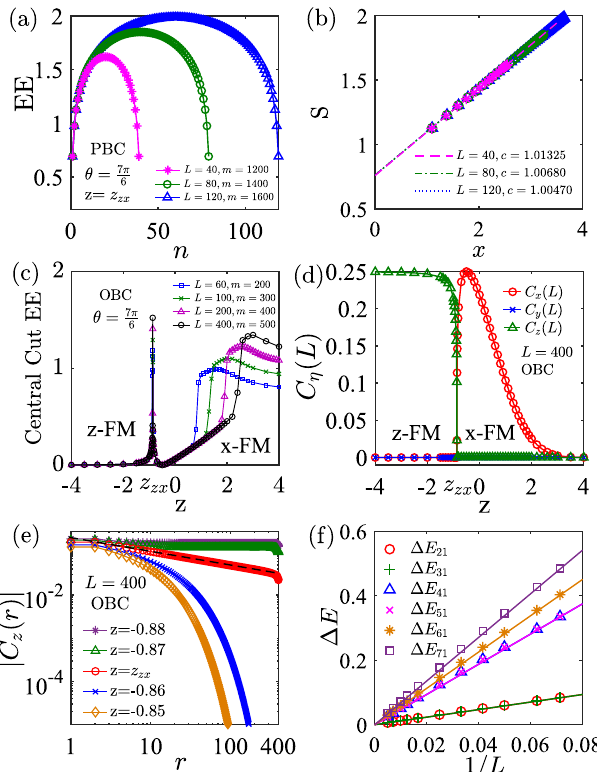
Figure 5. ( a ) and ( b ) show EE and central charge c at the boundary between z -FM and x -FM phase at 0.86602 , by DMRG method with PBC. The dashed lines in ( b ) are fitted by Eq. (28) 7 π/ 6 with z zx θ = − = sin π n ln ( L 1 . ( c ) Central cut EE as a function of z at θ 7 π/ 6 for different L and ) , yielding c with x π L = = = 7 π/ 6 for x , y , z ) as a function of z at θ bond dimension m . ( d ) Spin–spin correlation functions C η ( L ) ( η = = 0.32 , by 400 . ( e ) Spin–spin correlation function C 7 π/ 6 . At the phase boundary, C L z ( r ) at θ = z ( r ) ∝ | r | − = 1 / L for all n at the boundary ( θ 7 π/ 6 with DMRG method with OBC. ( f ) Scaling of excitation gaps δ E n 1 ∝ = 0.86602 ) as a function of chain length, indicating of gapless and z zx = −